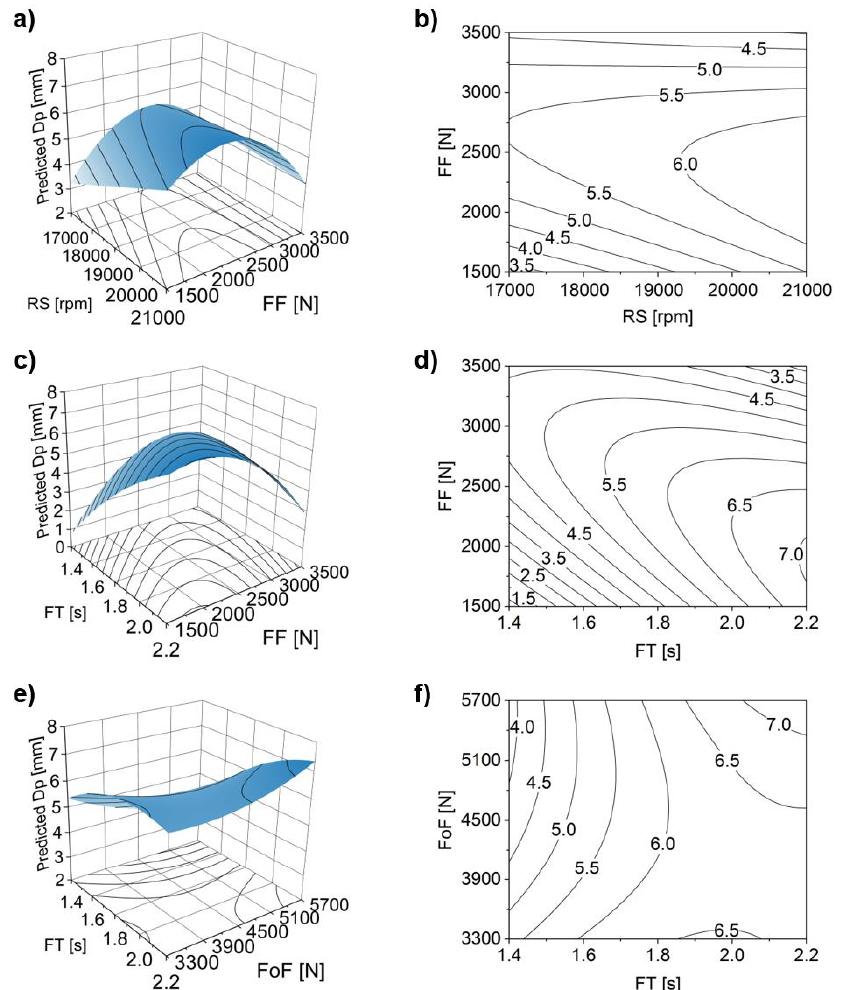
Figure 21. Two-way parameter interactions with anchoring depth, Dp. Surface and contour plots for: ( a ) rotational speed (RS) and ( b ) friction force (FF); ( c ) friction time (FT) and ( d ) friction force (FF); and forging time (FoT), ( e ), and forging force (FoF) ( f ).